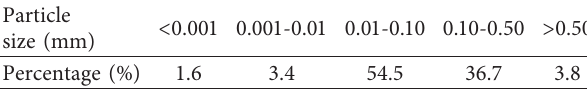
Figure 2. Parallel experiments were carried out for each group to ensure the accuracy of the test data.